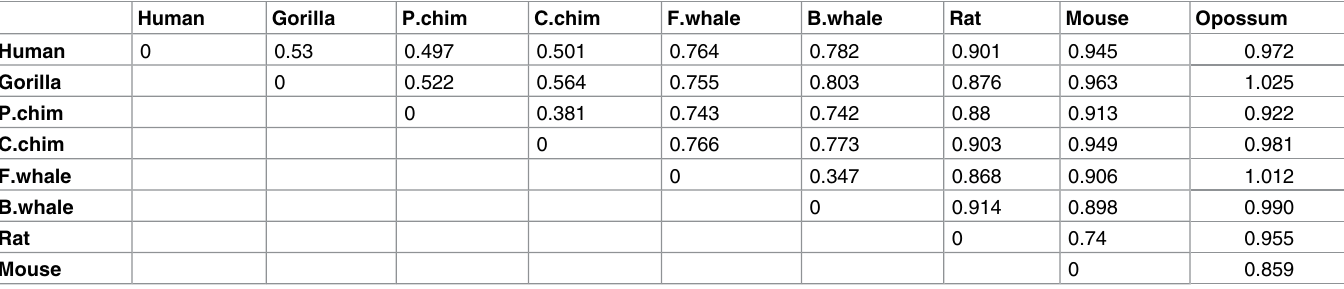
Table 2. The distance matrix of nine species by our